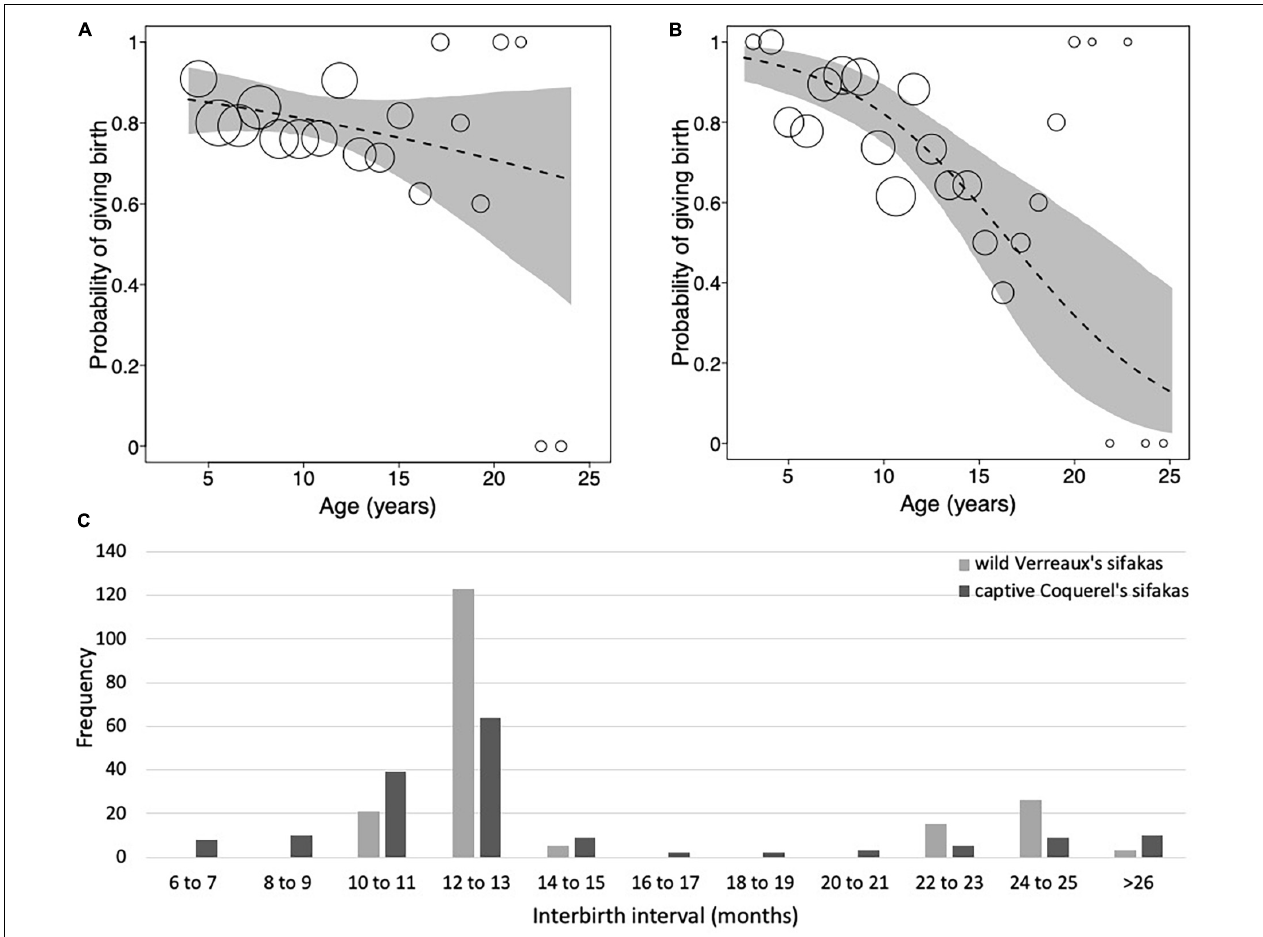
FIGURE 1 | Probability of giving birth as a function of mother’s age for (A) wild Verreaux’s sifakas and (B) captive Coquerel’s sifakas. (C) Frequency distribution of interbirth intervals of wild Verreaux’s sifakas (light gray; N = 193) and captive Coquerel’s sifakas (dark gray; N = 161). Dashed lines represent the regression lines, gray polygons represent the 95% confidence intervals, and dots represent the number of observations with the area of dots being proportionate to the number of observations per binned age (Verreaux’s sifakas: range 2–33, Coquerel’s sifakas: 2–26). Note that the dots in panels (A,B) are not to the same scale.